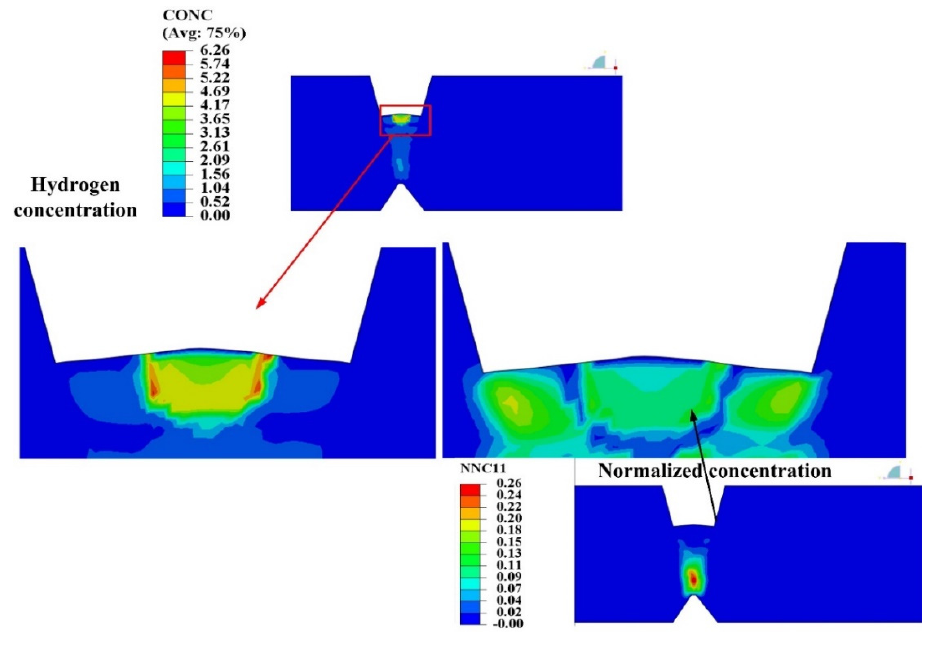
Figure 15. Self-gathering effect of welding process of heavy plate.